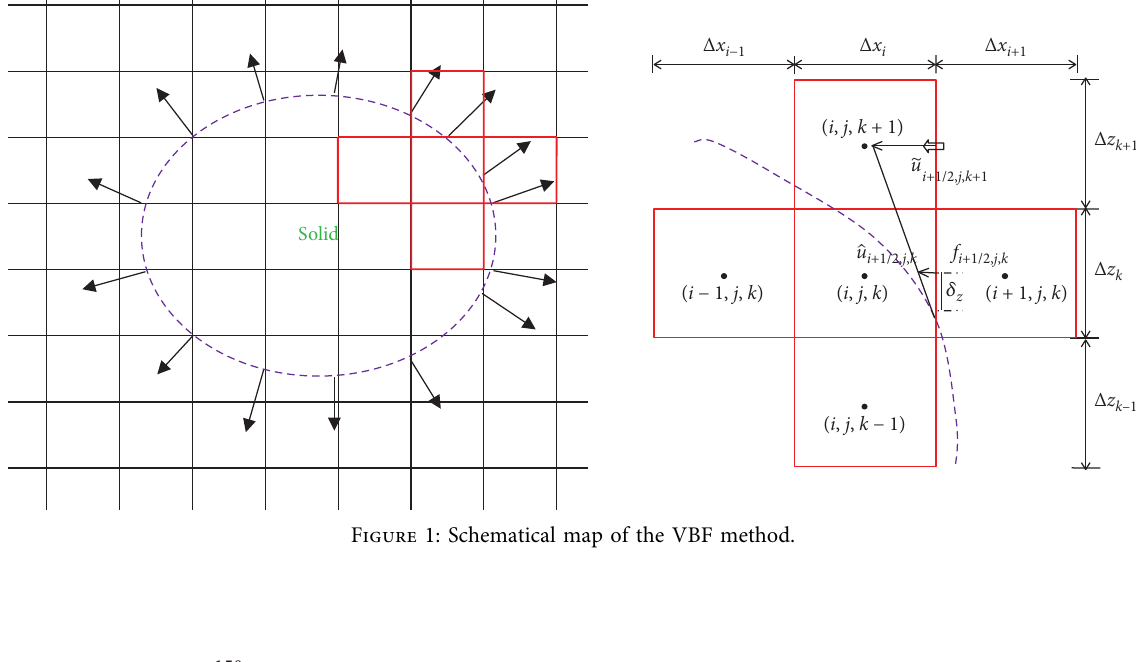
Figure 1: Schematical map of the VBF